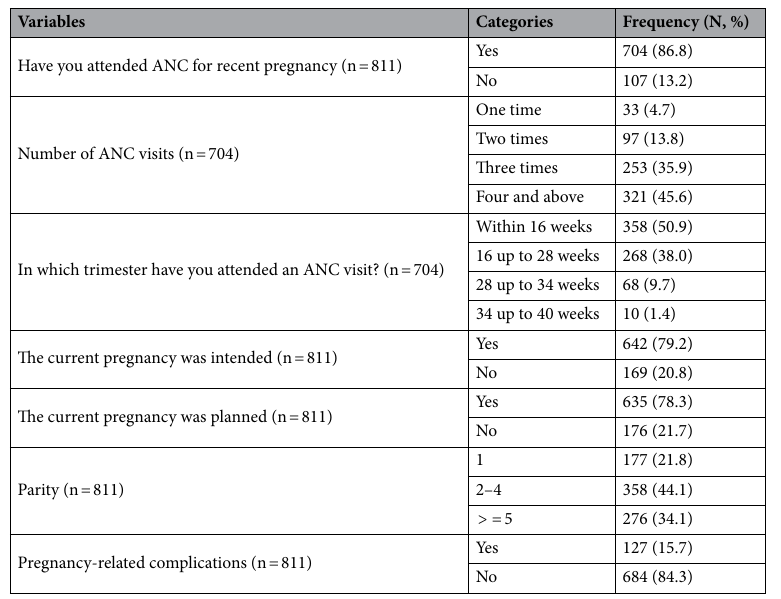
Table3. Antenatal care visit status and obstetric history among delivered mothers in Northwest Ethiopia, 2020.